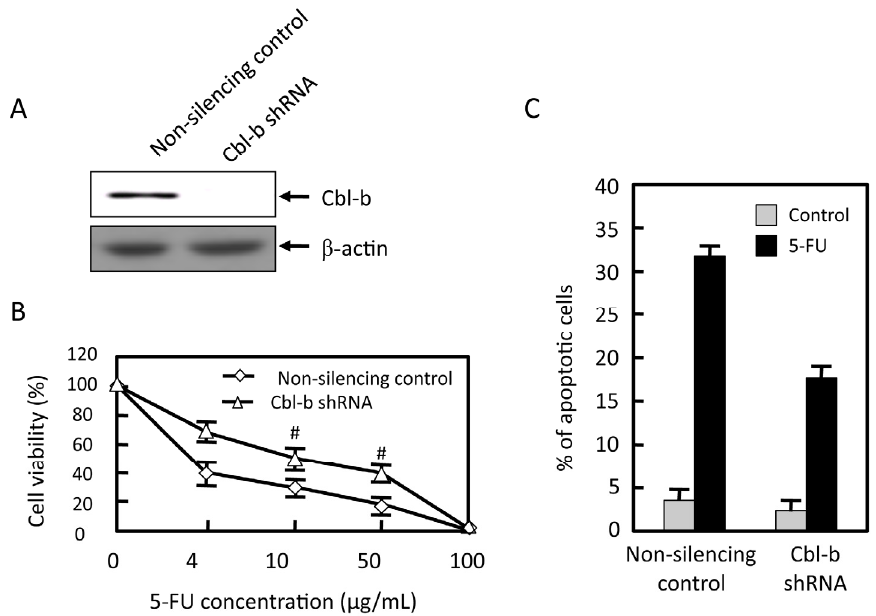
Figure 4. Effects of Cbl-b on 5-FU chemosensitivity. MGC803 cells were transfected by non-silencing control and Cbl-b shRNA. ( A ) Cbl-b and β -actinexpression were evaluated by western blot; ( B ) Then cells were treated with the indicated concentration of 5-FU for 48